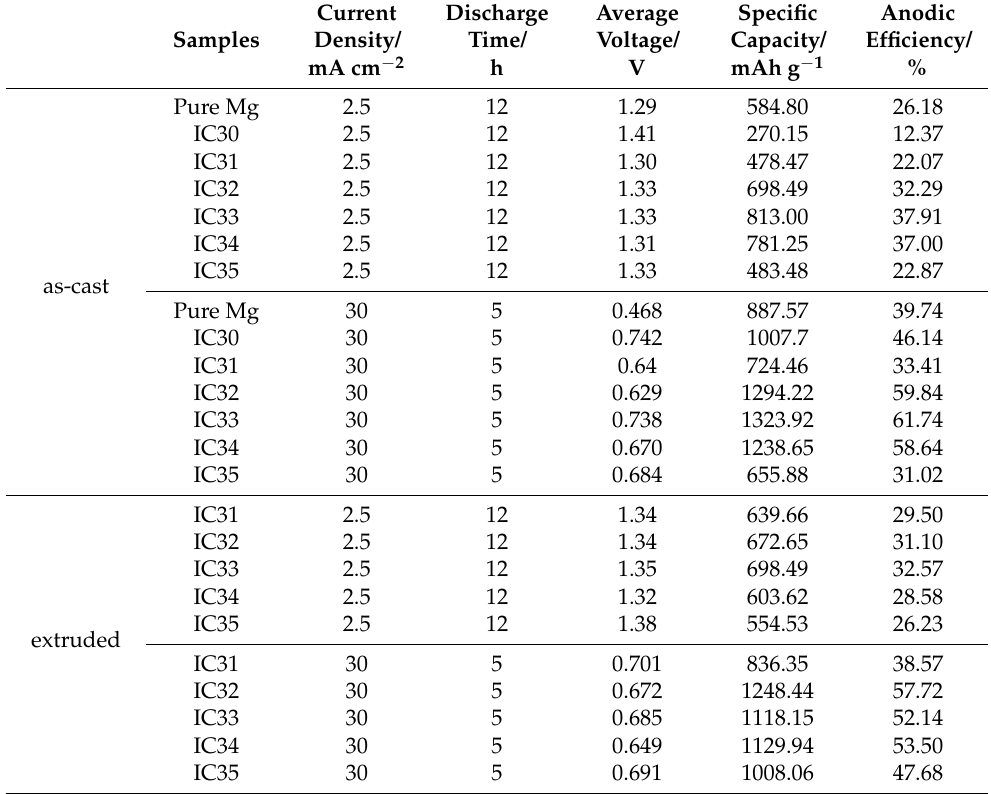
Table 2. Discharge parameters of Mg–air batteries with different alloy anodes at different current